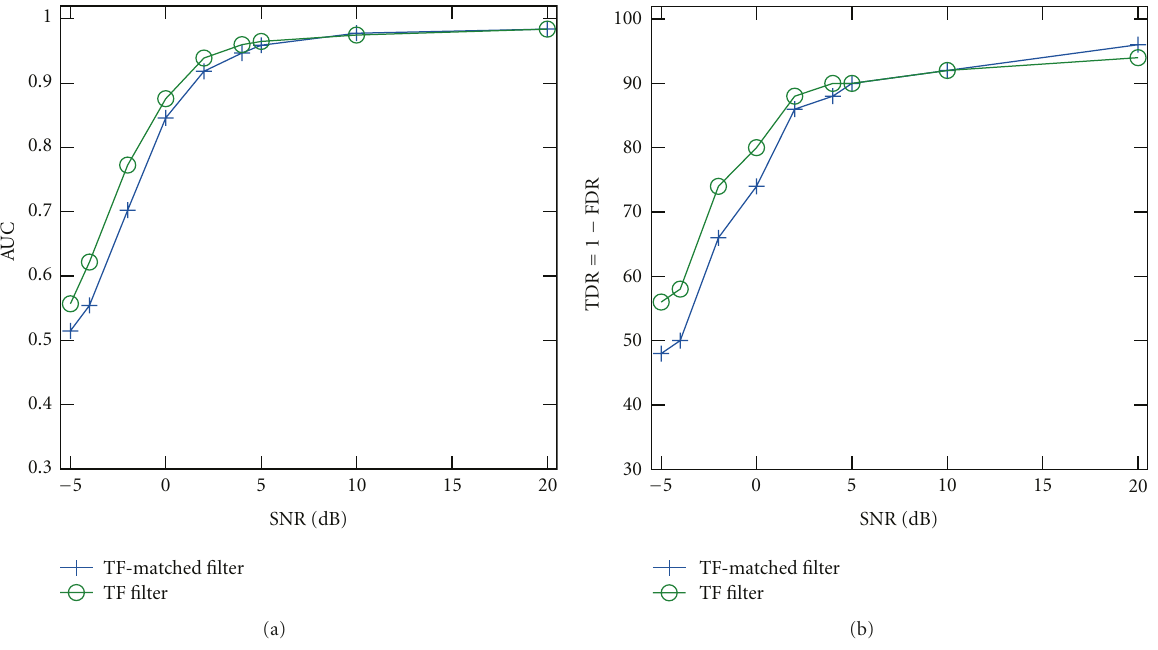
Figure 15: Detection results for coloured Gaussian noise with high-energy harmonics.